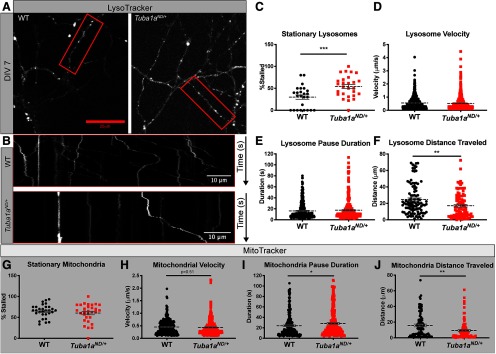
Tuba1aND/+neurons have deficits in organelle transport caused by increased stationary cargoes. A, Still images from time-lapse microscopy of DIV3 cortical neurons labeled with LysoTracker dye to mark lysosomes in wild-type (WT) and Tuba1aND/+neurons. B, Representative kymograph plots of lysosome movement over time within select neurites for wild type (top) and Tuba1aND/+(bottom). C, Scatter plot representing the percent of stationary lysosomes per kymograph in wild-type and Tuba1aND/+neurons. Data points represent individual neurons (N = 3 mice, n = 25 neurons, p = 0.001). D, Scatter plot representing lysosome velocities in μm/s for wild-type and Tuba1aND/+neurons. Data points represent individual lysosomes (n = 635 lysosomes, p = 0.27). E, Scatter plot representing pause duration (s), for moving lysosomes in wild-type and Tuba1aND/+neurons. Data points represent individual pause events (n = 338 events, p = 0.56). F, Scatter plot representing total distance traveled (μm) by moving lysosomes in wild-type and Tuba1aND/+neurons. Data points represent individual lysosomes (n = 87, p = 0.003). G, Scatter plot representing the percentage of stationary mitochondria in wild-type and Tuba1aND/+neurons. Data points represent individual neurons (N = 3 mice, n = 30 neurons, p = 0.34 by). H, Scatter plot the velocity of short mitochondrial movements in wild-type and Tuba1aND/+neurons. Data points represent individual mitochondria (N = 3 mice, n = 301 mitochondria, p = 0.45). I, Scatter plot representing pause duration (s), for moving mitochondria in wild-type and Tuba1aND/+neurons. Data points represent individual pause events (n = 417 events, p = 0.79). J, Scatter plot representing total distance traveled (μm) by moving mitochondria in wild-type and Tuba1aND/+neurons. Data points represent individual mitochondria (n = 86, p = 0.01). Cortical neurons from three animals per genotype were analyzed. Lysosomes were imaged once every second for 3 min, mitochondria were imaged once every 2 s for 2 min. Statistical differences between groups were assessed by Student’s t test; **p < 0.01; ***p < 0.001. In all plots, line designates mean with error bars indicating SEM. *p < 0.05; **p < 0.01; ***p < 0.001.